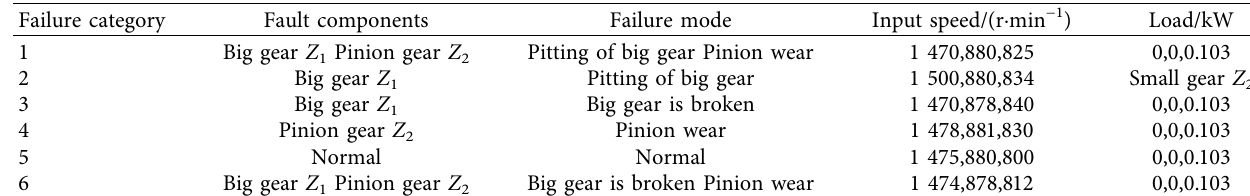
Figure 3: Flow of the improved GMO-KELM method. Table 1: Description of gearbox